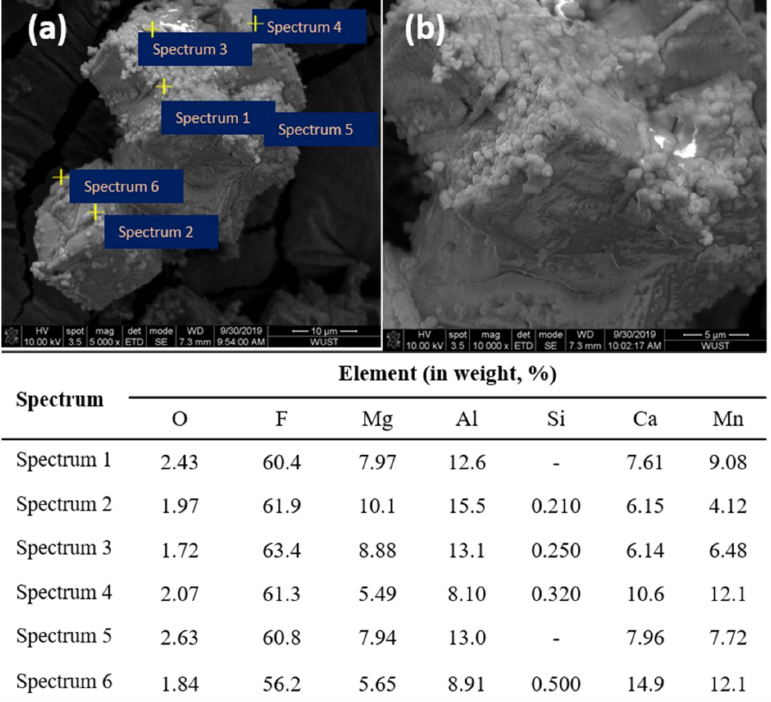
Figure 12. SEM-EDS analysis for the precipitate obtained during purification with MnNH 4 F 3 , ( a ) magnification × 5000, ( b ) magnification × 10,000